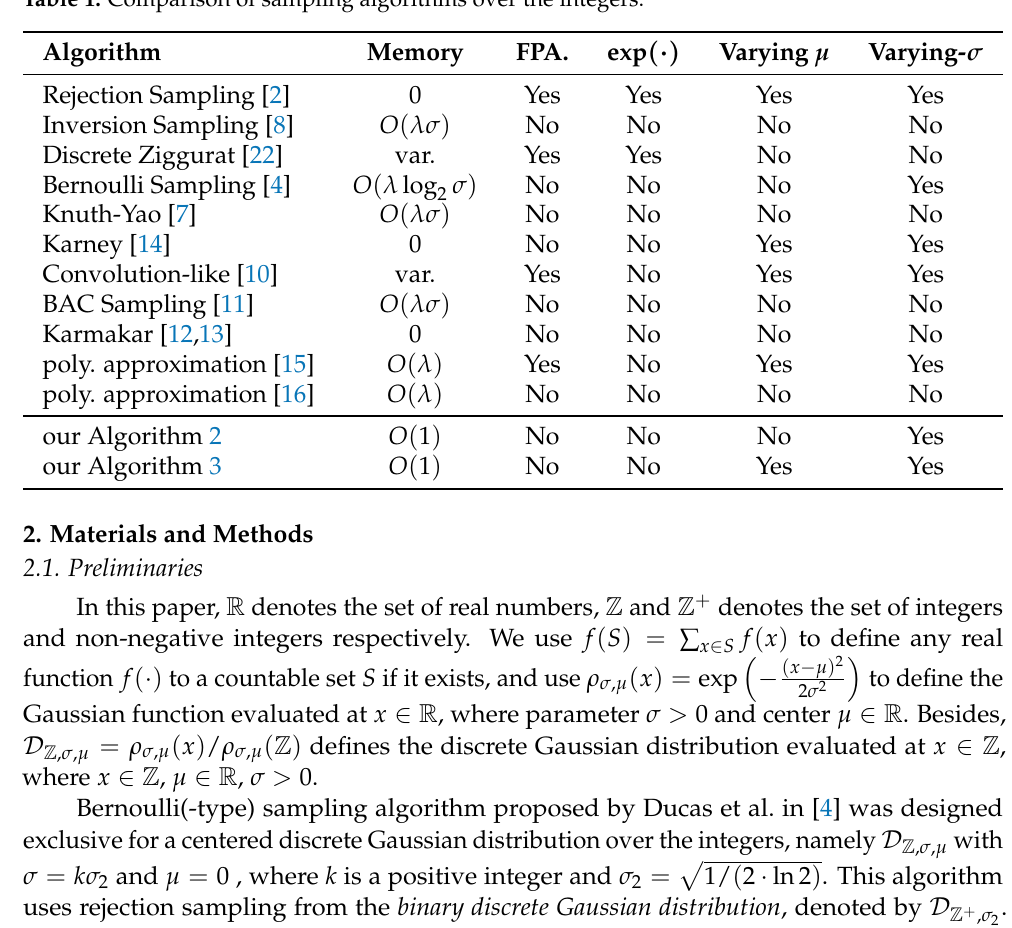
Table 1. Comparison of sampling algorithms over the